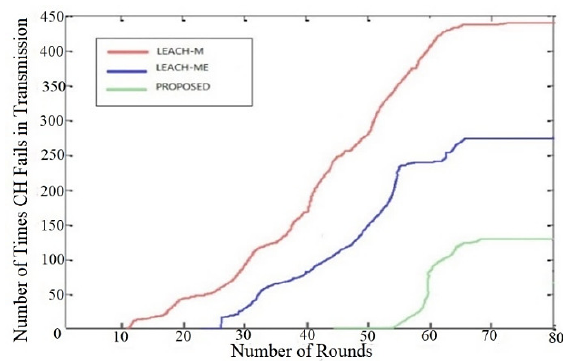
Fig. 15. Total number of transmitted packets versus round number.